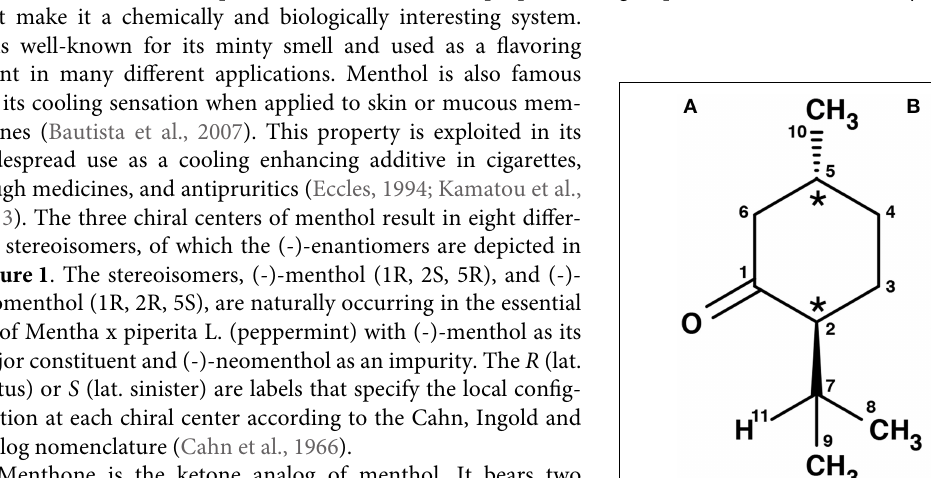
our sample, (-)-menthol (1R, 2S, 5R) is expected to be the main component. The three stereogenic centers are marked with stars in (A) .